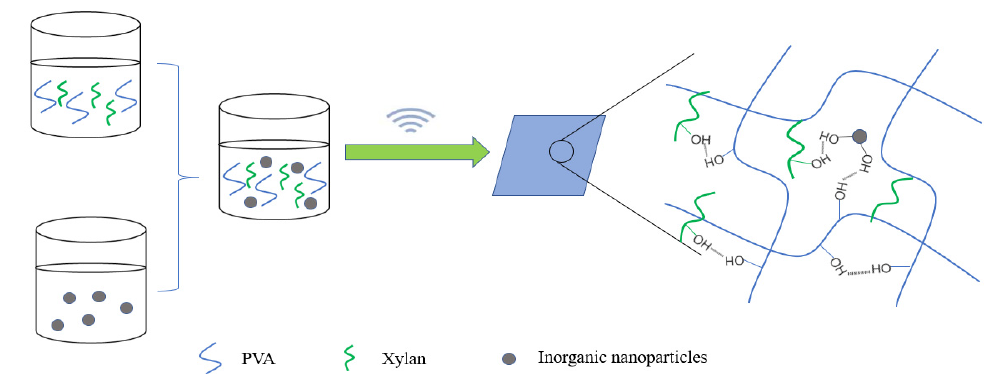
Figure 6. Synthesis of inorganic nanoparticles and PVA/xylan composite film.